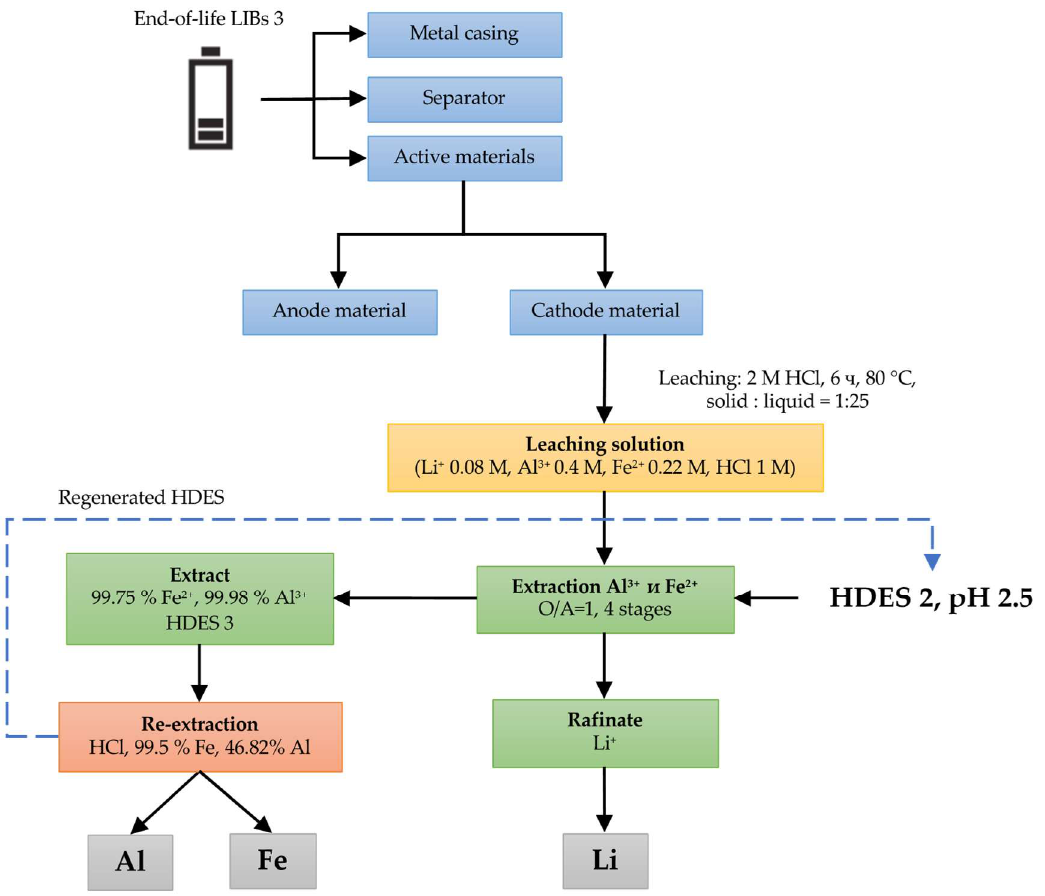
Figure 10. Scheme of LIB 3 treatment by leaching with hydrochloric acid and extraction with HDESs. Re-extraction of Fe(II) and Al(III) ions was carried out with a 4 M HCl solution. The extraction of Fe(II) and Al(III) ions into the aqueous phase was 99.5% and 46.82%, respectively, in three stages. After that, the metal ions were extracted and separated by precipitation. The residual Al(III) ions were also re-extracted from the HDES phase by cross-current extraction with 4 M HCl solution.